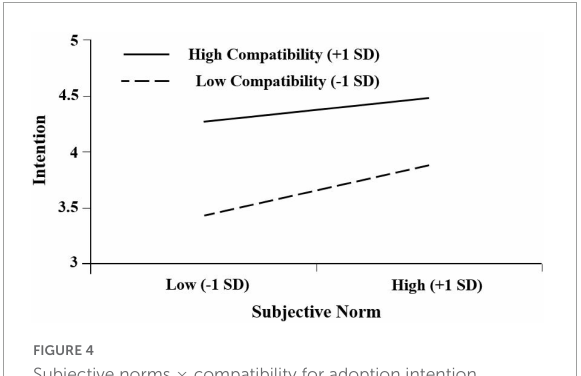
FIGURE4 Subjective norms × compatibility for adoption